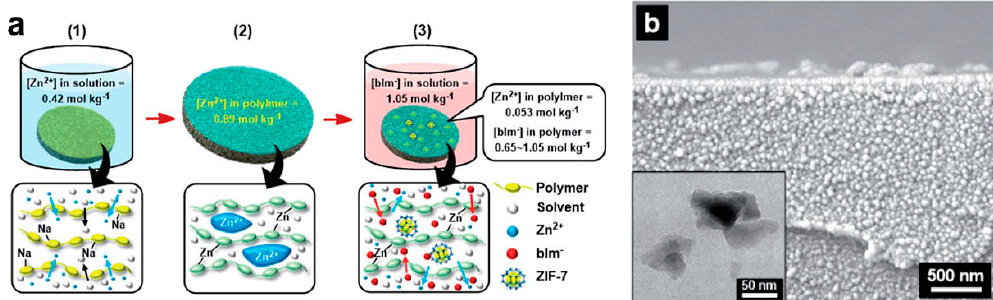
Figure 5. ( a ) Illustration of the in situ growth of ZIF-7 in PI matrix. ( b ) Scanning electron microscope image of the cross- section of the ZIF-7/PI MMM. The inset shows a transmission electron microscope image of the in situ formed phase III ZIF-7 fillers in the PI matrix. Reprinted with permission from ref. [99] . Copyright 2020 Royal Society of Chemistry.